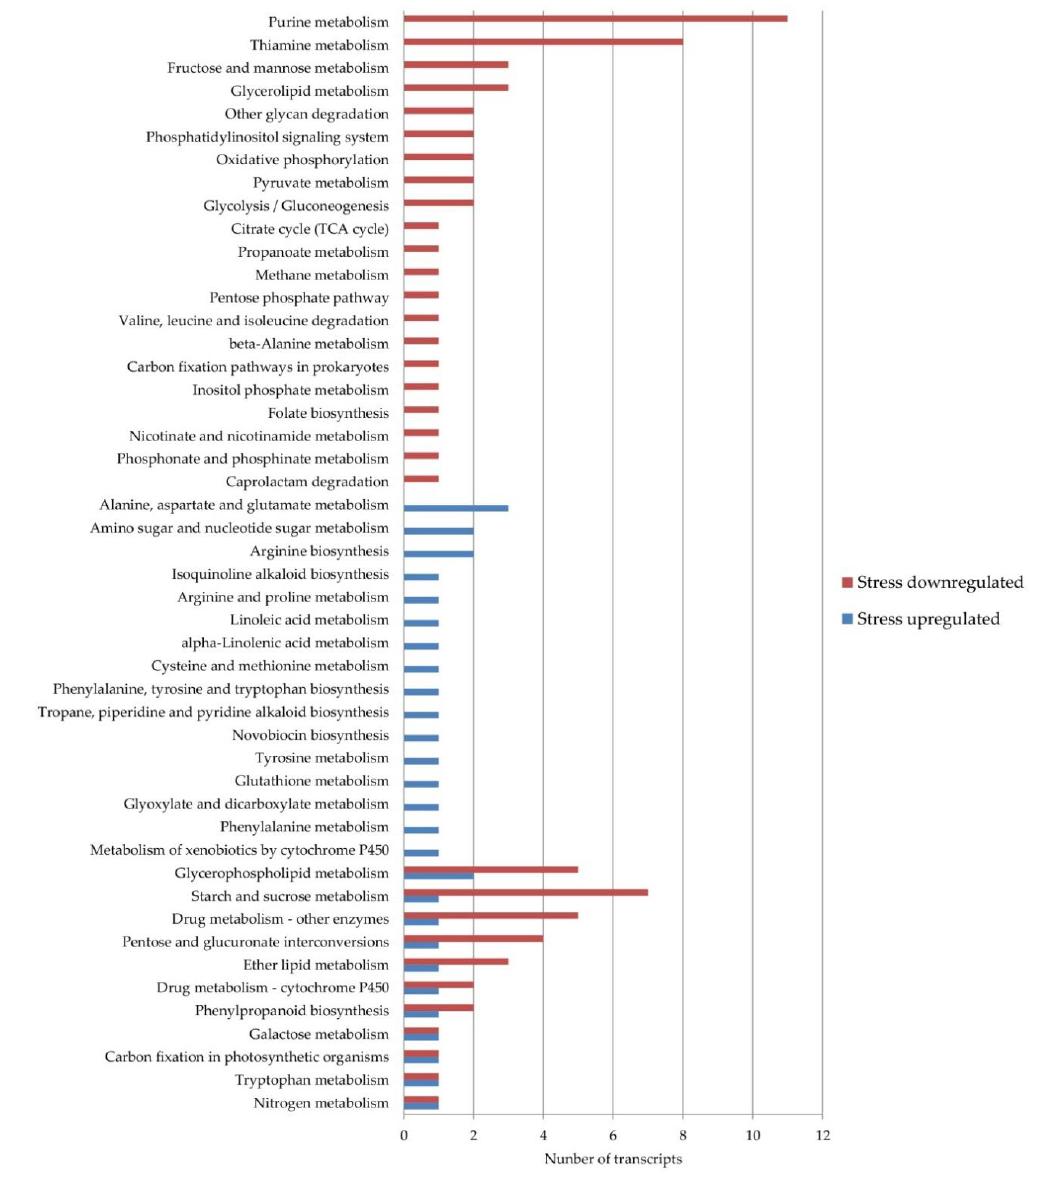
Figure 2. Weeping lovegrass differentially expressed the transcripts present in Kyoto Encyclopedia of Genes and Genomes (KEGG) pathways. The blue bars show the number of transcripts upregulated and the red bars show the number of transcripts downregulated under stress conditions in each pathway.